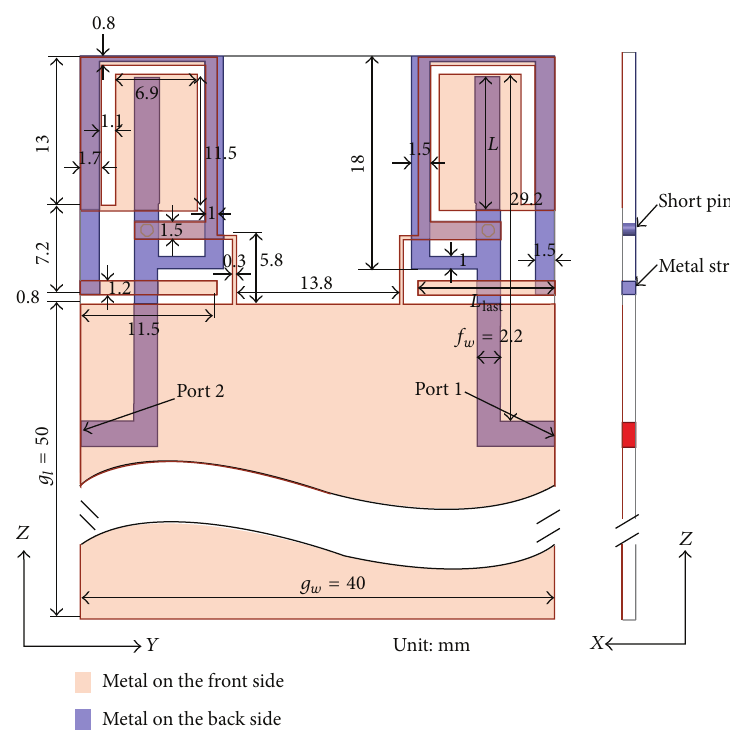
Figure 1: Structure of the proposed MIMO antenna.